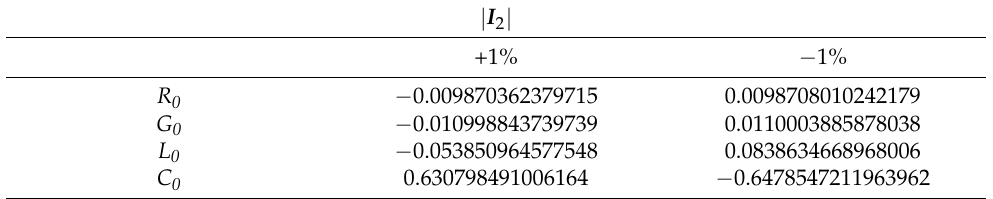
Table 10. Changes to the I 2 current